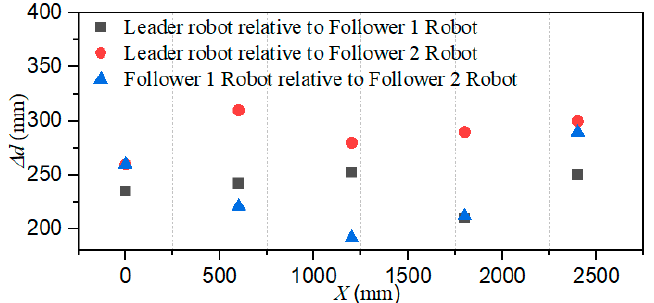
Figure 22. Relative localization o ff set with a lateral queue. ( ∆ d is the relative distance between two robots).